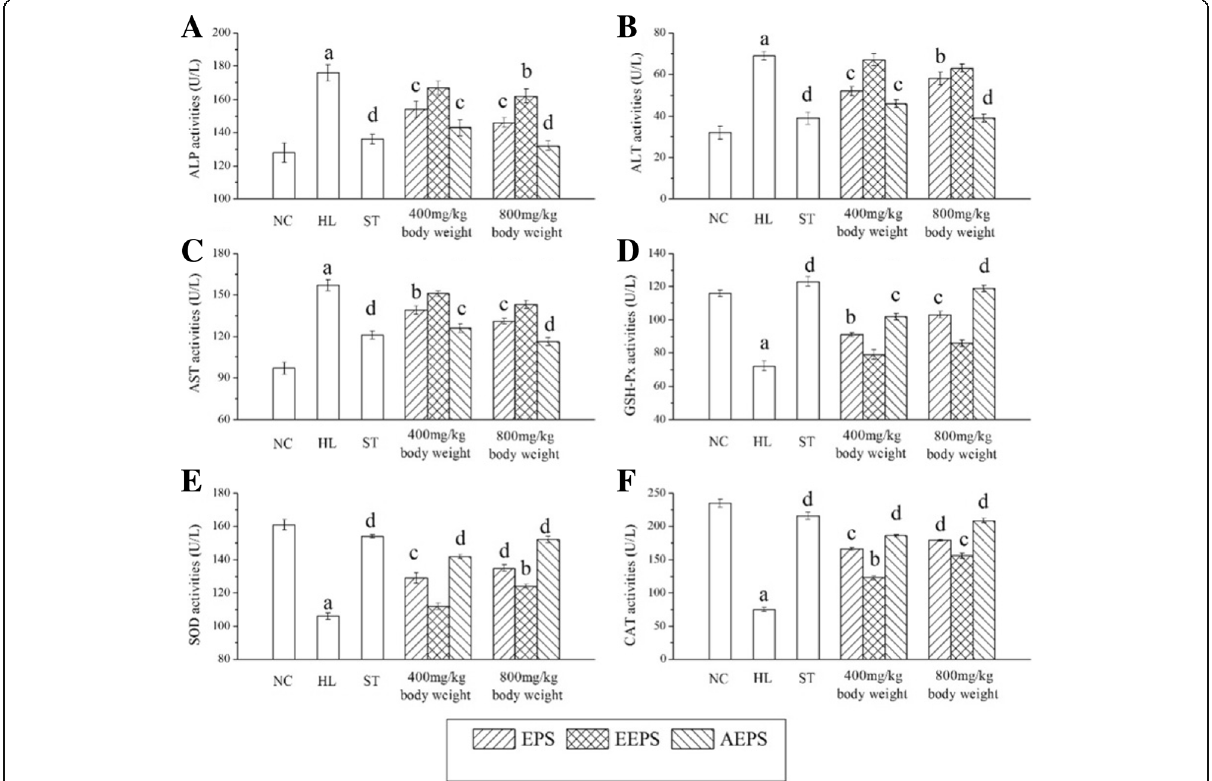
Fig. 3 Effects of EPS, EEPS and AEPS on activities of ( a ) ALP, ( b ) ALT, ( C ) AST, ( d ) GSH-Px, ( e ) SOD and ( f ) CAT in serum. The values were reported as the mean ± SD of eight mice per group. a Significant 306 difference compare to NC, P < 0.001. b Significant difference compare to MC, P < 0.01. c Significant difference compare to MC, P < 0.05. d Significant difference compare to MC, P <